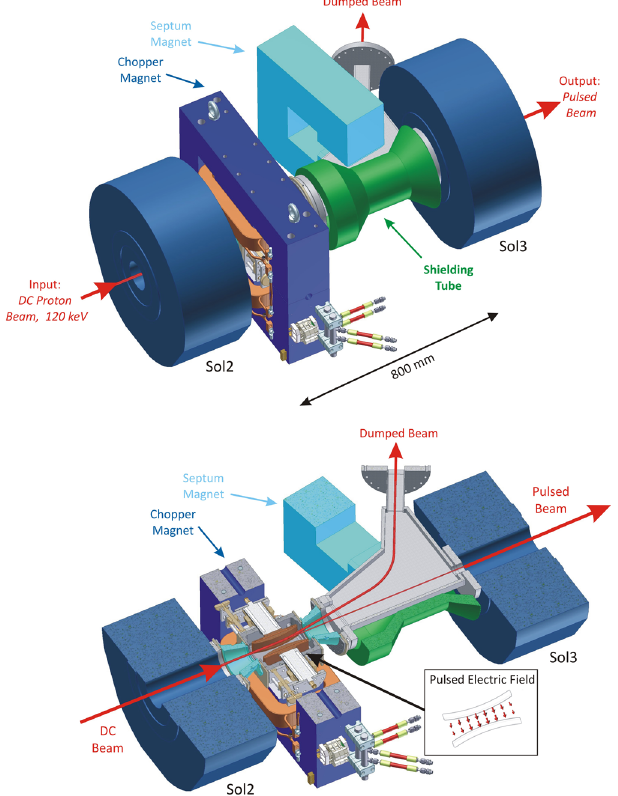
FIG. 2. Schematic overview of the E × B chopper: perspective view (top) and cross sectional view (bottom). The chopper is installed in the LEBT section between Solenoid 2 and 3. Figure was modified from [29]. The total length, including the beam- separation system, is 80 cm.